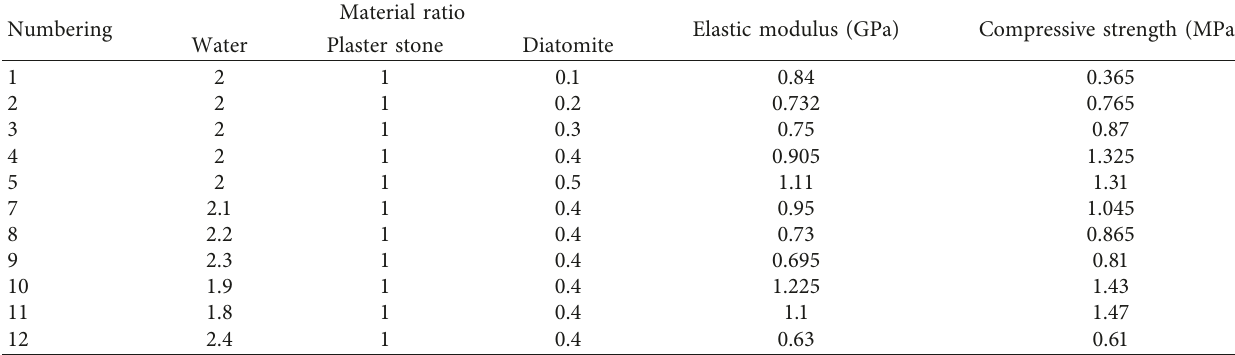
Table 2: Material ratios of mixed material and mechanical parameters of tunnel lining.